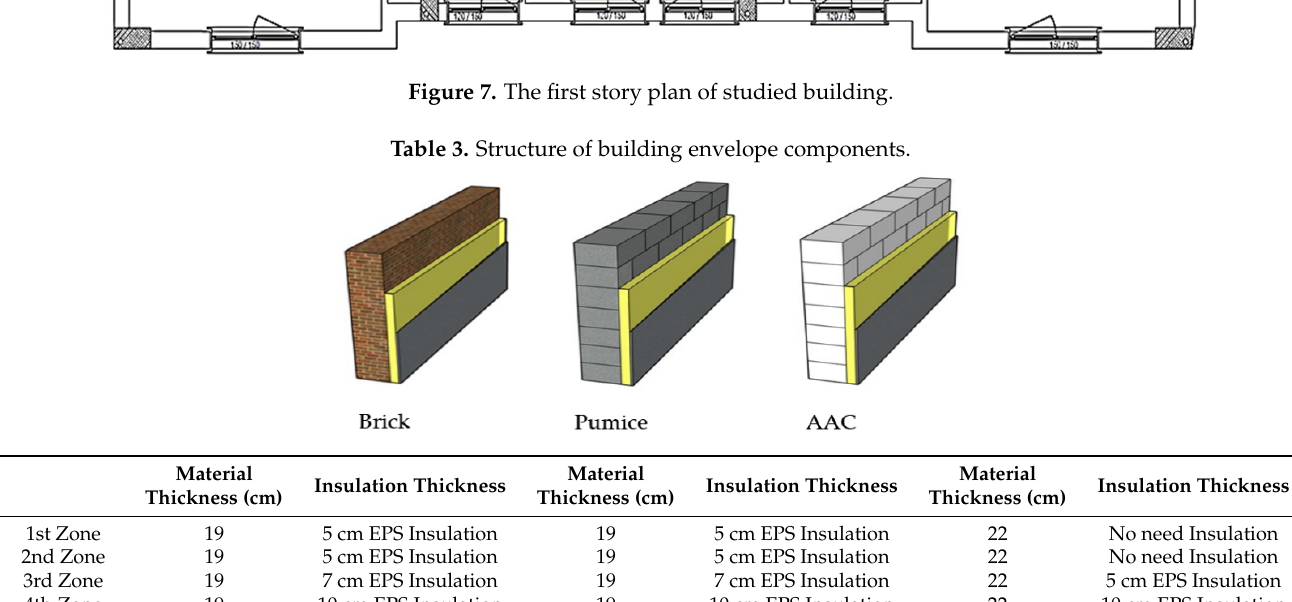
Figure 7. The first story plan of studied building.